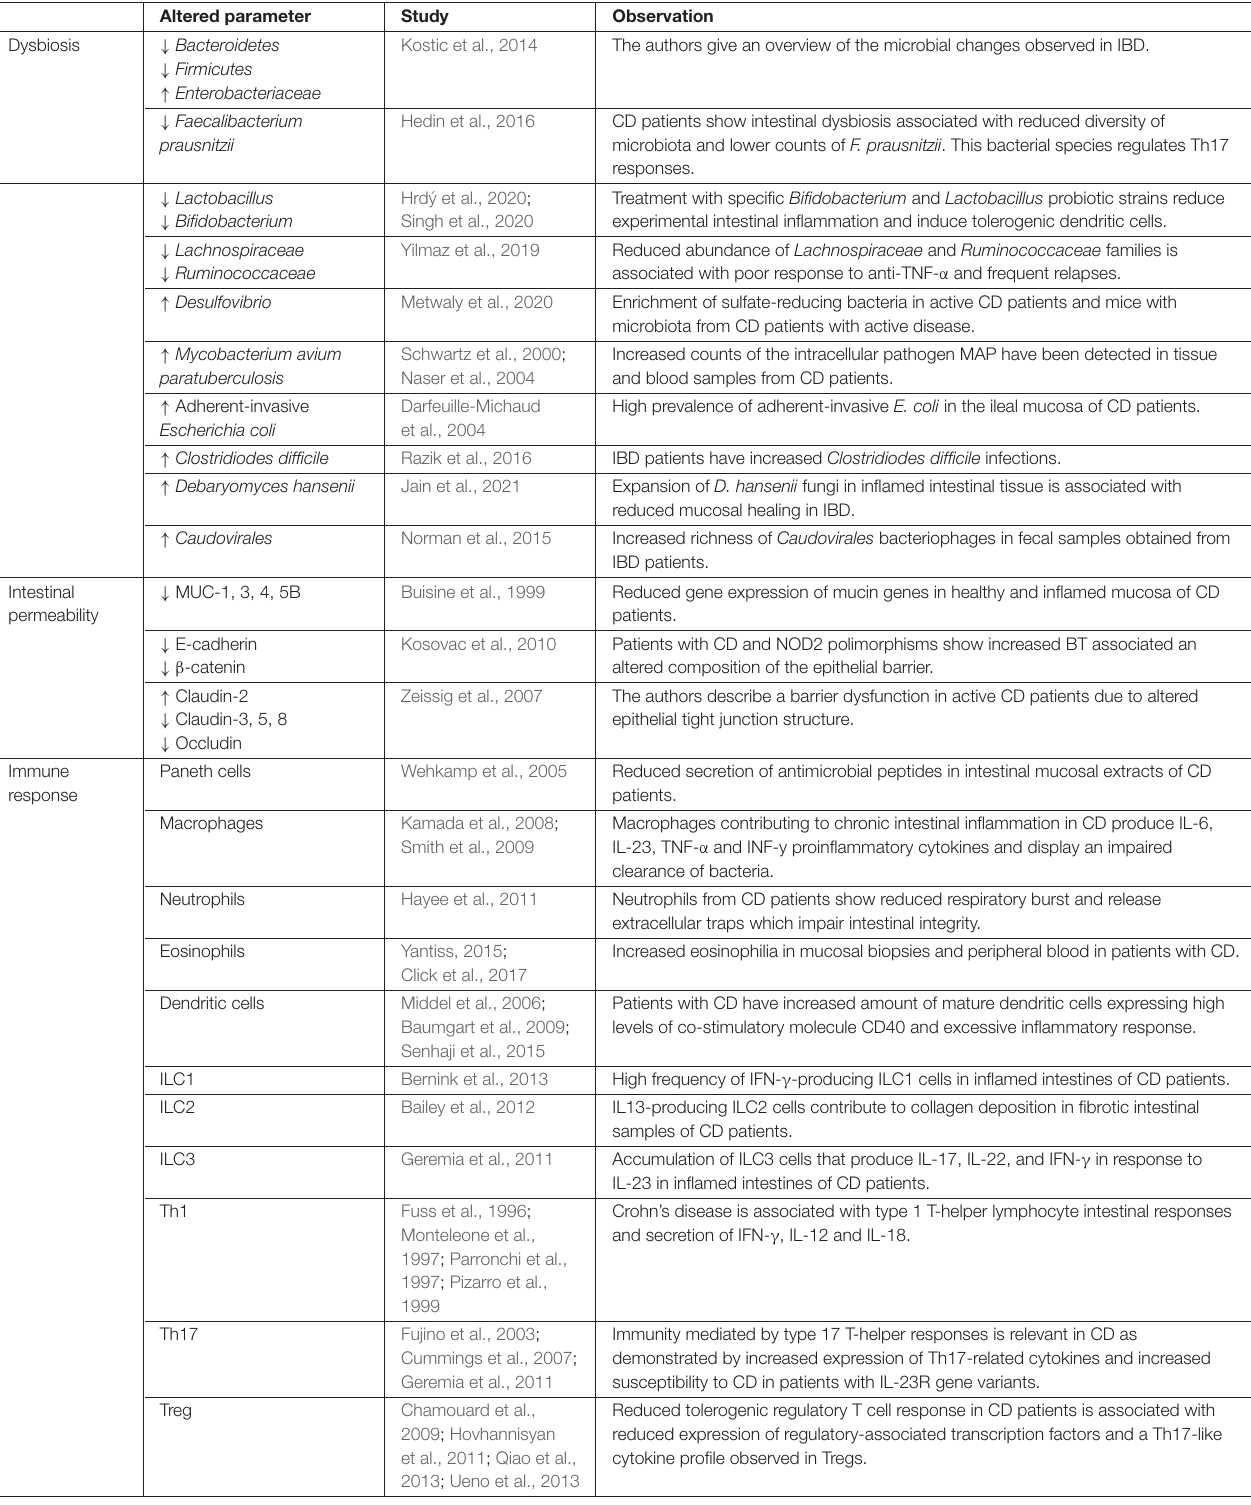
TABLE 1 | Risk factors for bacterial translocation in Crohn’s disease include intestinal dysbiosis, altered intestinal integrity, and immune